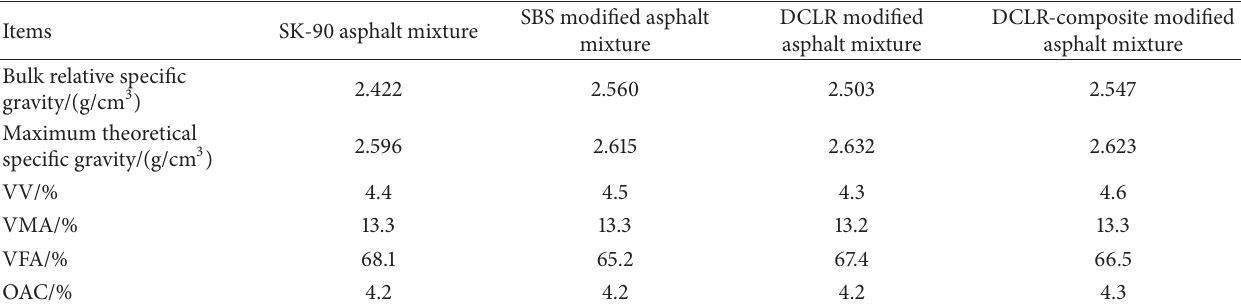
Table 6: Volumetric indexes of the asphalt mixtures.